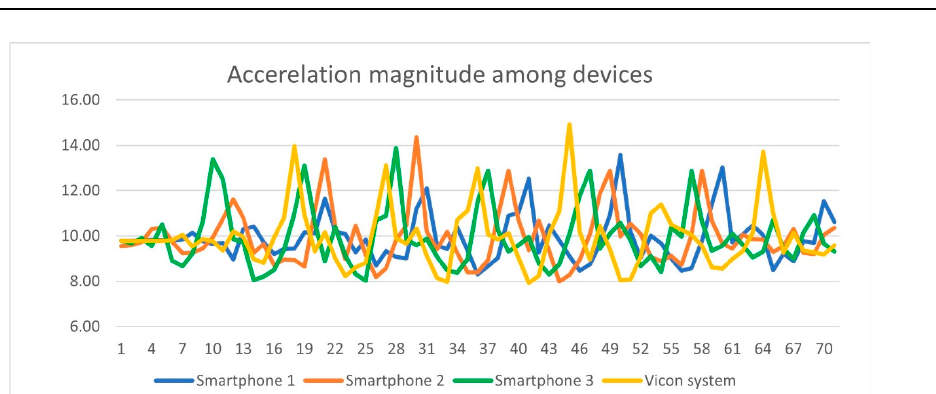
Figure 9. Intraclass Correlation Coefficient values among device’s acceleration magnitude.